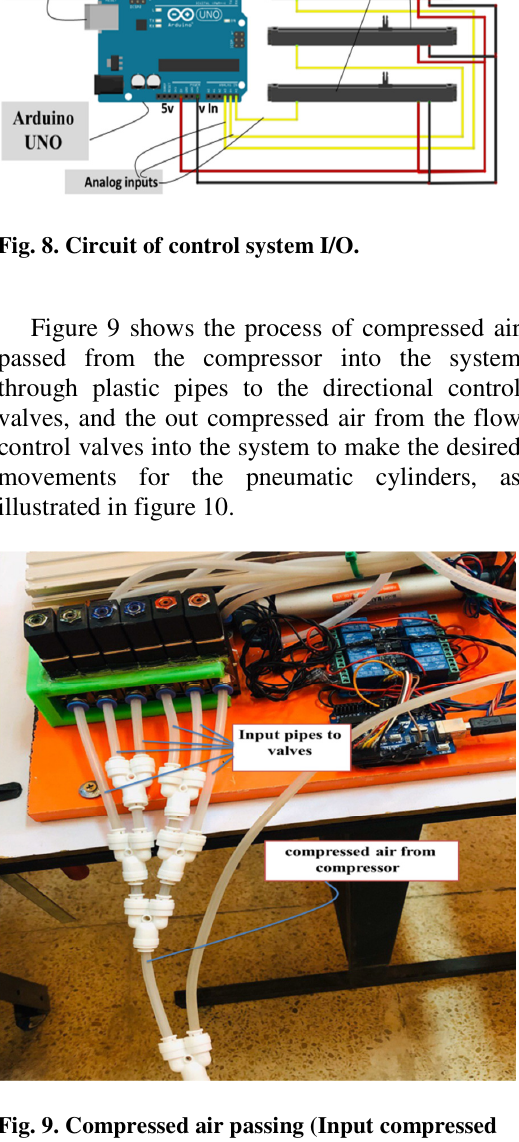
Fig. 9. Compressed air passing (Input compressed air) to the system.